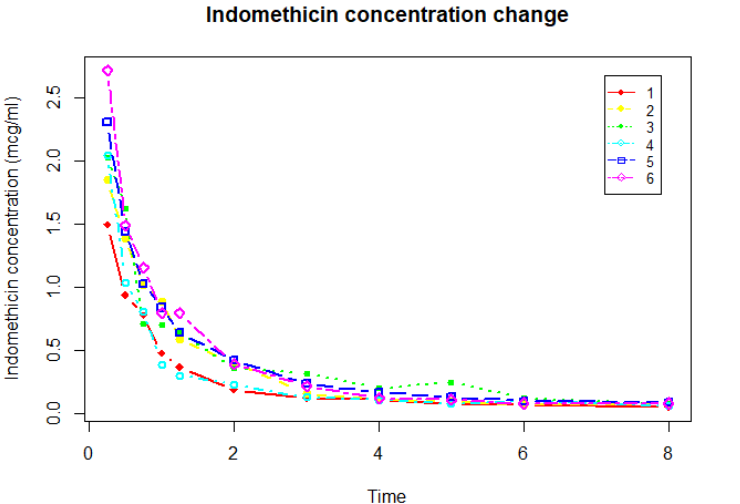
Figure 2. Indomethicin concentration (mcg/mL) of six individuals measured 11 times after